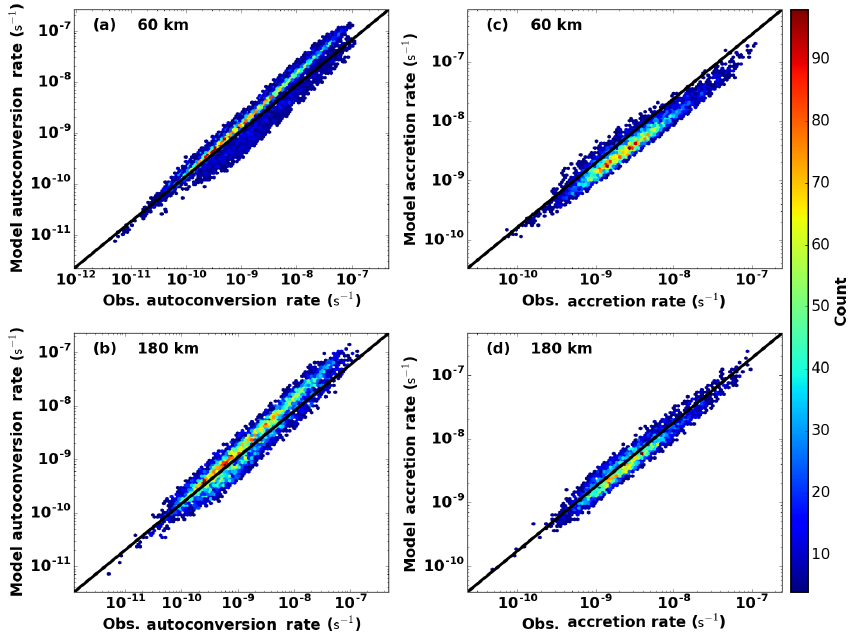
Figure 3. Comparison of autoconversion (a–b) and accretion (c–d) rates derived from observations ( x axis) and from the model ( y axis). Results are for 60km (a, c) and 180km (b, d) model equivalent sizes. Colored dots represent joint number densities.